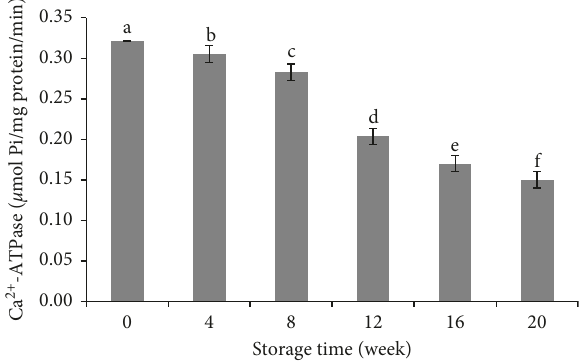
Figure 6: Changes in protein solubility of the Basa fish fillet during frozen storage at − 20 ° C for 20 weeks. Bars represent standard deviation from triplicate